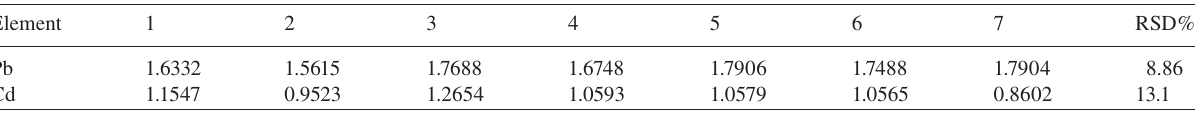
Table 4 Precision determination results (ng/ml).